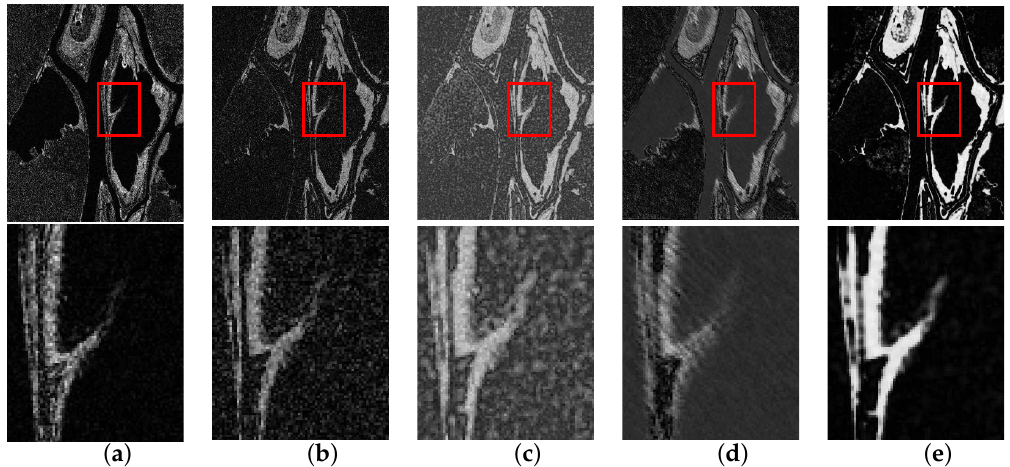
Figure 17. The DIs generated by different methods in the Ottawa data set: ( a ) subtraction, ( b ) log-ratio, ( c ) wavelet fusion, ( d ) SCCN, and ( e ) DADNN. The first row shows the full DI and the second row a zoomed-in region.